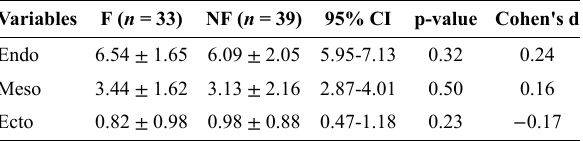
Table 2 - Somatotype values in frail and non-frail older adults.